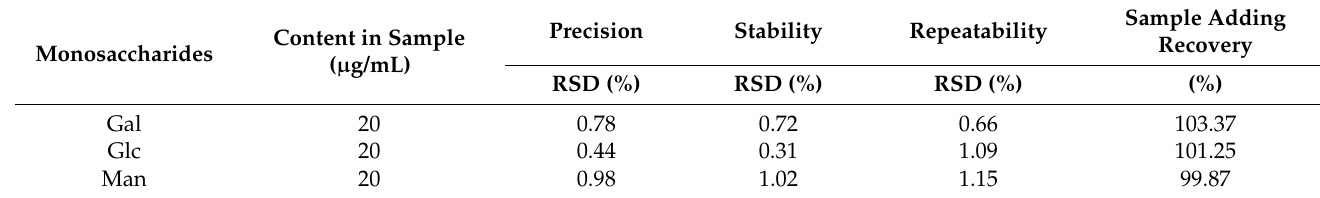
Table 5. Precision, stability, repeatability, and accuracy of